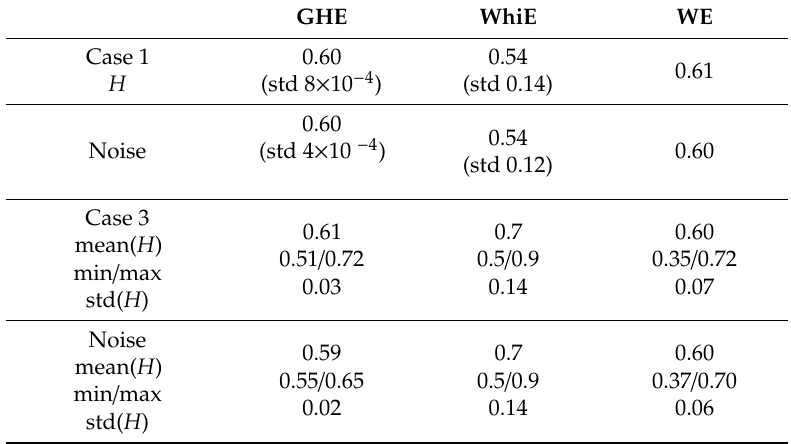
Table 1. Estimation of the Hurst parameters from the residuals for case 1 and case 3, for the three estimators under consideration. We give additionally the standard deviation of the estimation, when available. Case without additional angle noise, H ref =